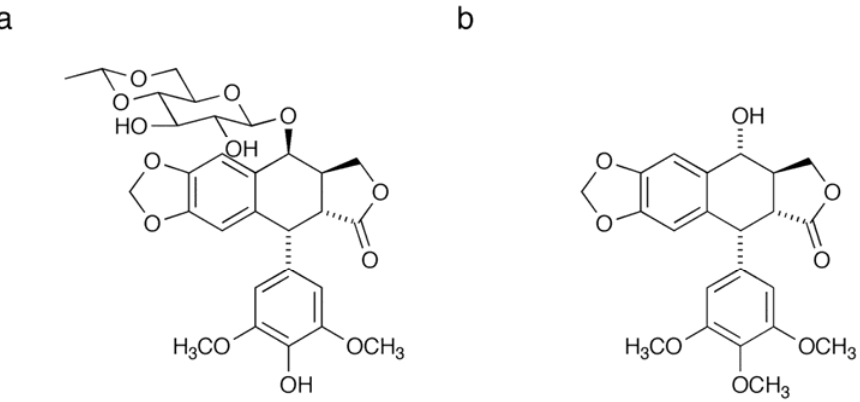
Figure 1. Structure of etoposide ( a ) and podophyllotoxin ( b